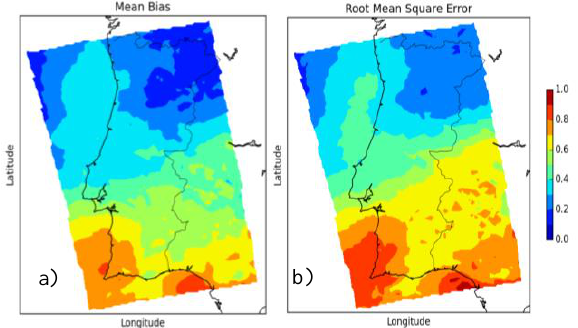
Figure 9. Mean Aerosol Optical Depth (AOD) shown for 10th- 17th May 2011. a) Spatial distribution obtained from CAMx data and b) Spatial distribution of SEVIRI data.